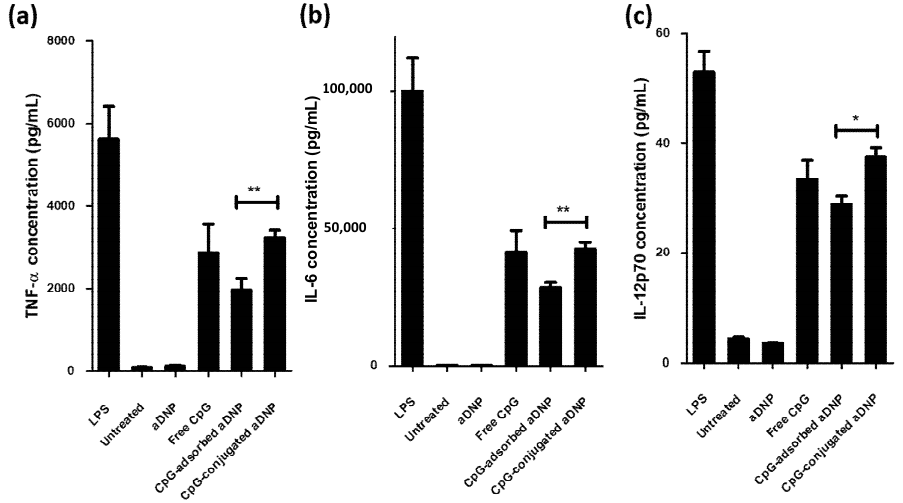
Figure 8. Production of cytokines, ( a ) TNF- α , ( b ) IL-6, and ( c ) IL-12p70, by bone marrow derived dendritic cells. The data are presented as mean ± standard error of the mean (S.E.M.) of three independent experiments. Statistical significance was determined with two-tailed Student’s t test. * p < 0.05; **, p <